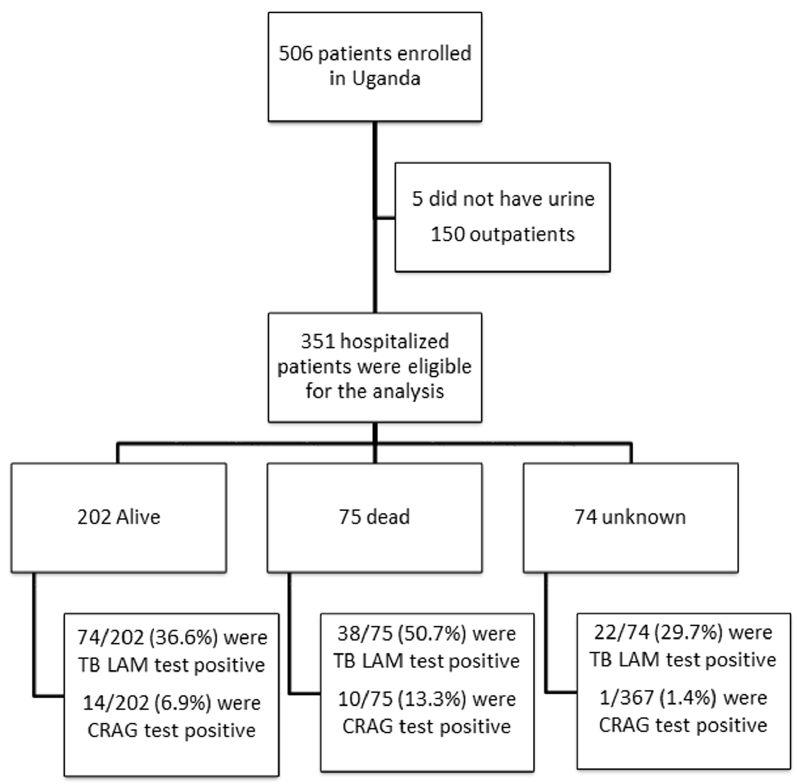
Figure 1. Study participant flow chart.